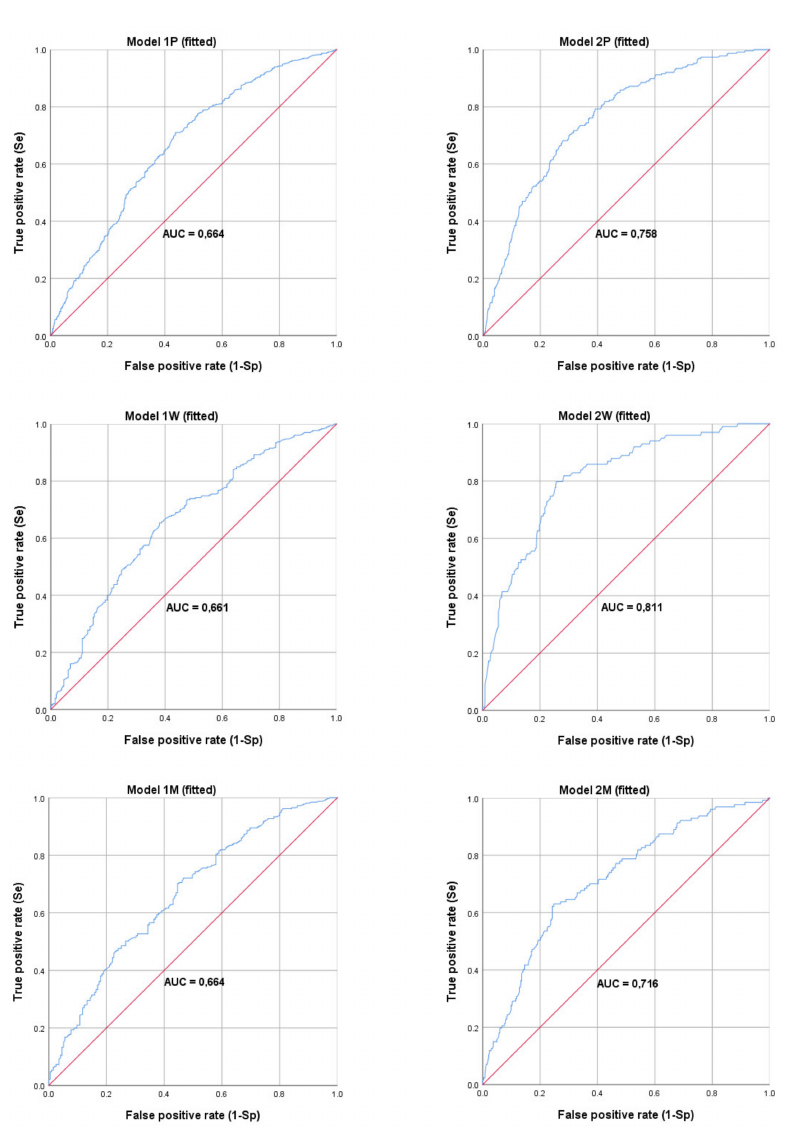
Figure A2. Receiver operating characteristic (ROC) curves for estimated models. Note: blue line—ROC curve; red line—reference line (line of classifications made by the random model); AUC—area under